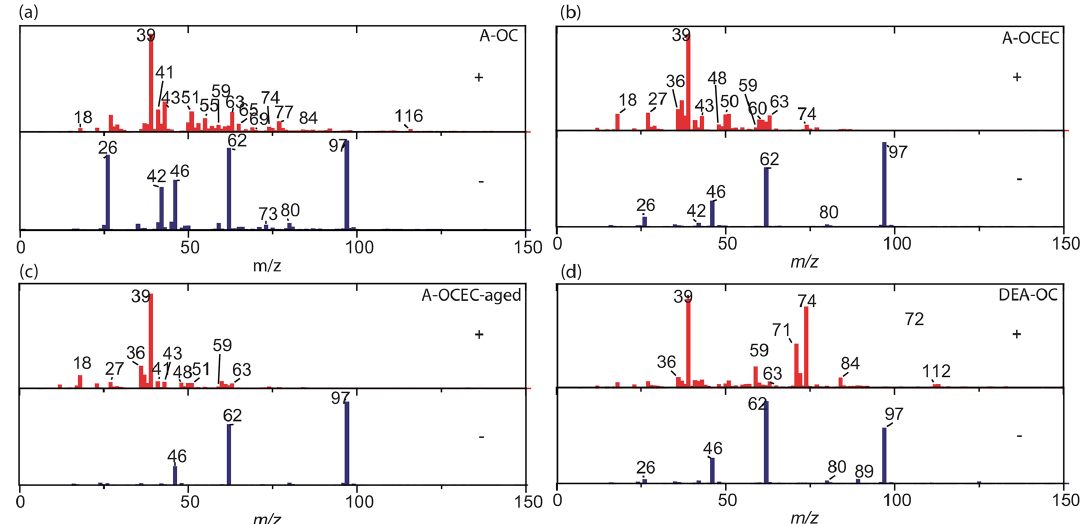
Figure 6. Average mass spectra of major particle types clustered from amine-containing